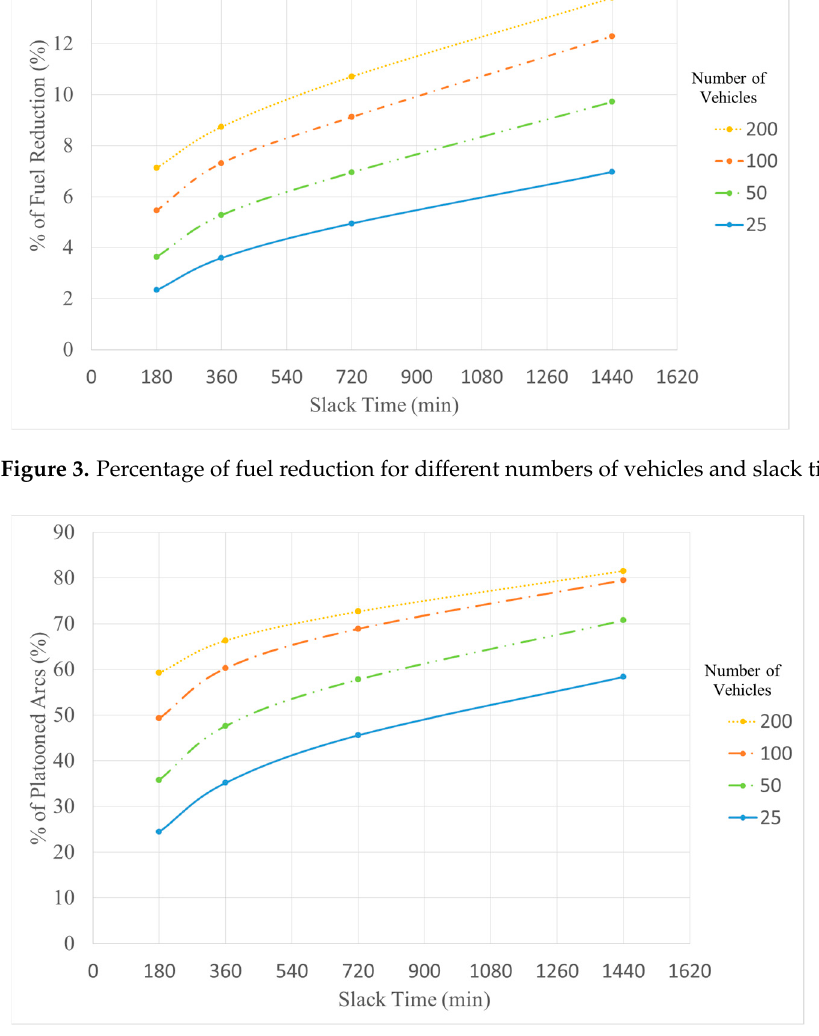
Figure 4. Percentage of platooned arcs for different numbers of vehicles and slack times.